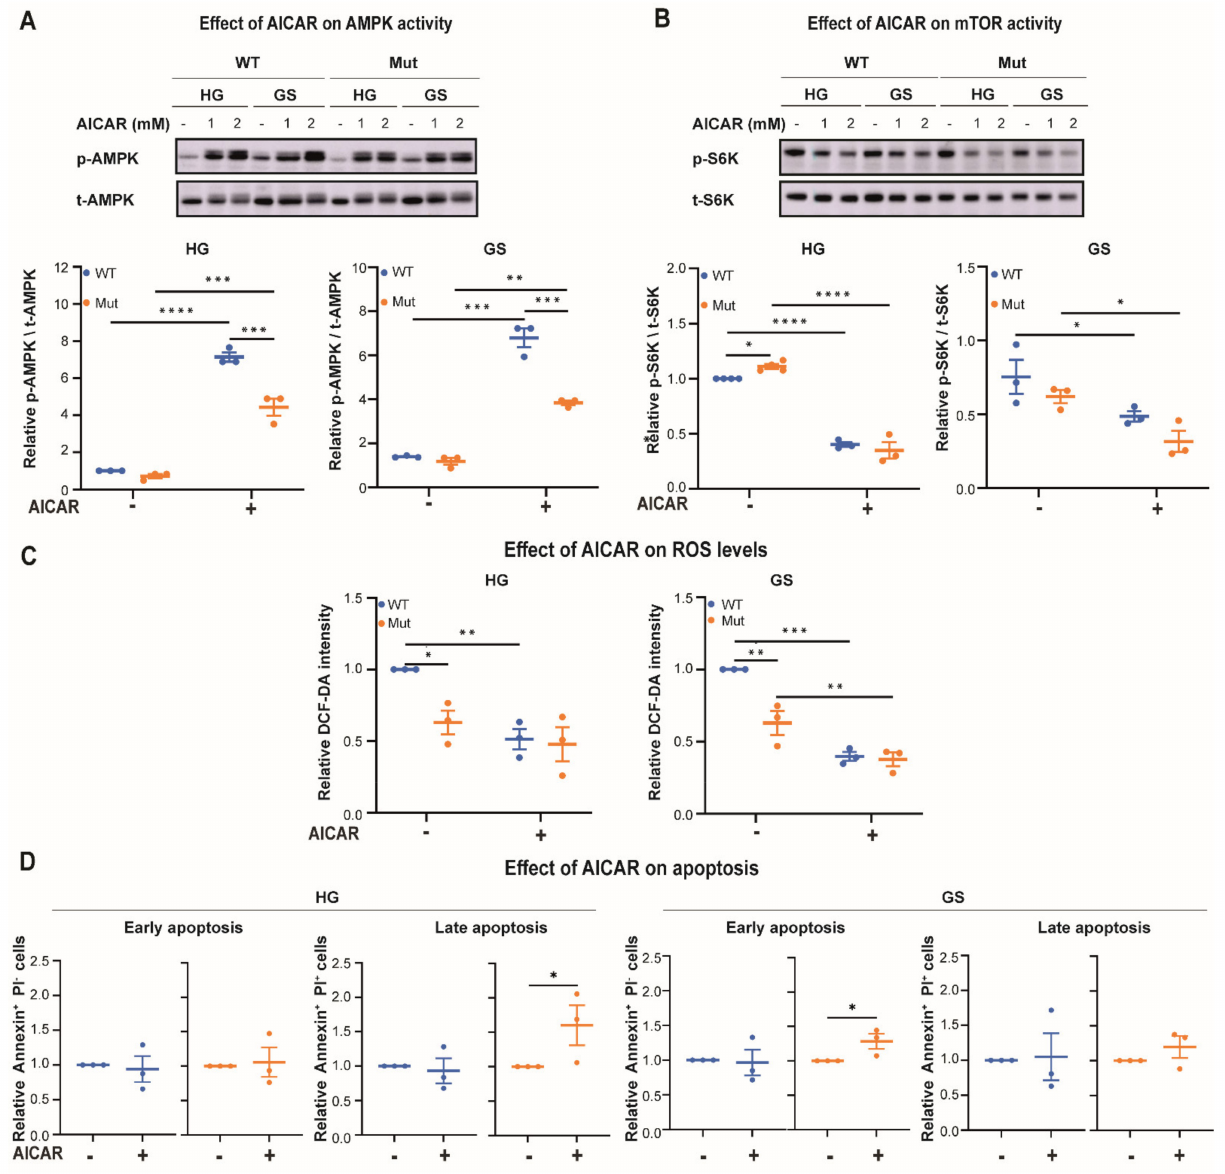
Figure 7. Effect of AICAR on WT (blue) and Mut (orange) primary astrocytes. ( A , B ) Cells were grown for 48 h in DMEM-HG or DMEM-GS medium and treated or not for the last two hours with 1 or 2 mM AICAR followed by analysis. ( A , B ) Total protein extracts were subjected to immunoblot analyses using antibodies for p-AMPK and t-AMPK ( A ), or p-S6K and t-S6K ( B ). Representative blots are shown. Data represent the effect of 2 mM AICAR and show the average of the indicated ratios ± SEM normalized to untreated WT-HG. ( C , D ) Cells were stained with DCF-DA ( C ), or FITC-conjugated Annexin-V antibodies and propidium iodide (PI) ( D ), followed by flow cytometry analyses for the detection of ROS level and cell death, respectively. Data represent average ± SEM of mean DCF-DA fluorescence intensity relative to WT ( C ), or fold change of Annexin positive|PI negative or Annexin positive|PI positive cells, relative to untreated controls ( D ). Statistical analysis is detailed in Materials and Methods. * p ≤ 0.05, ** p ≤ 0.01, *** p ≤ 0.001, **** p ≤